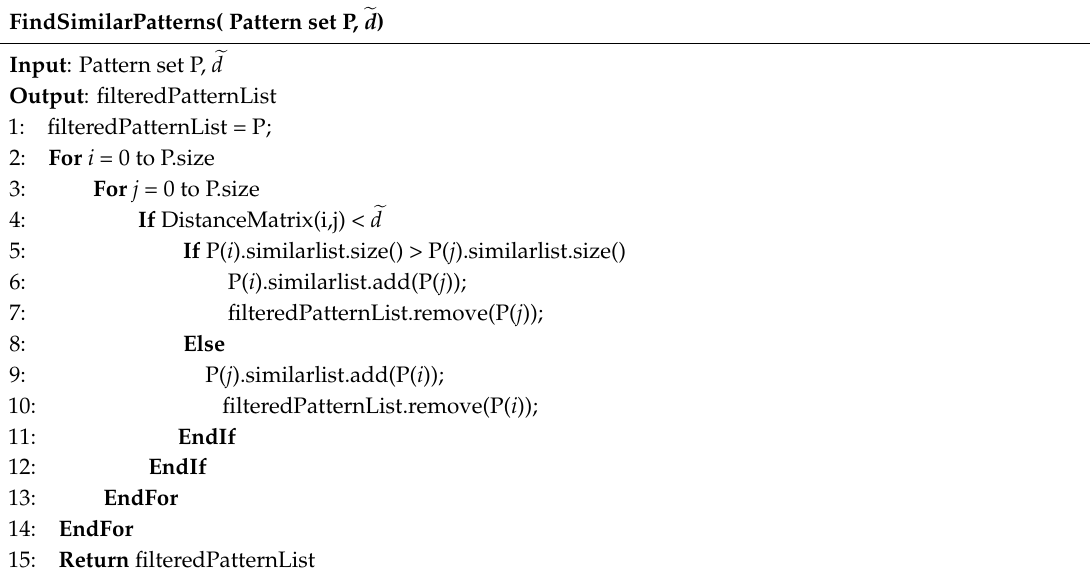
Algorithm 3. FindSimilarPatterns